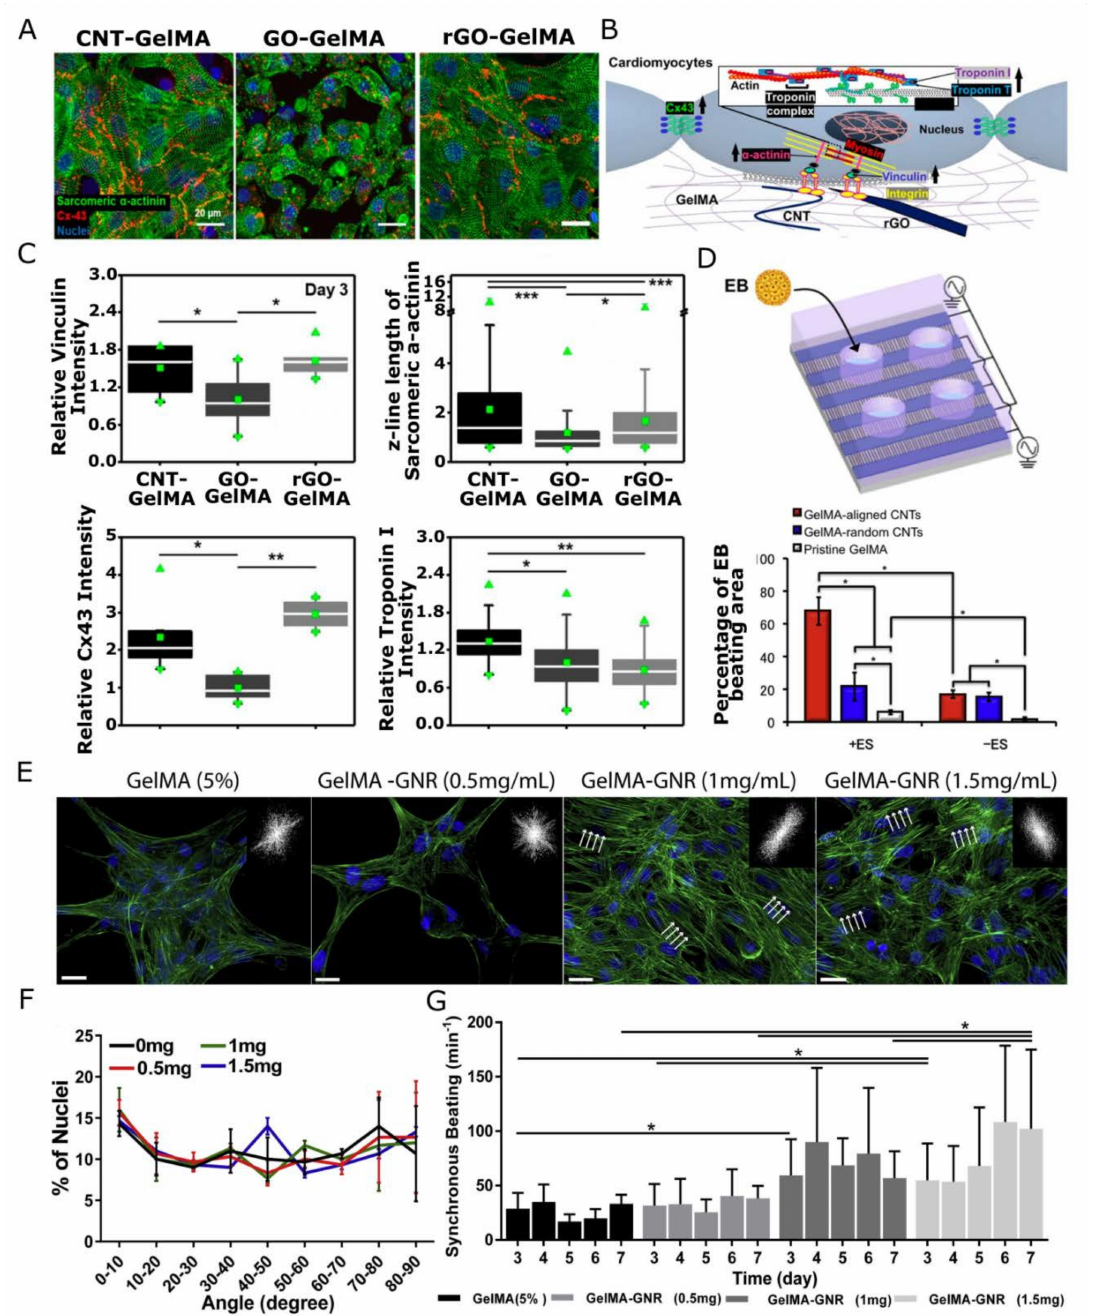
Figure 3. ( A ) Cardiac phenotypes on CNT-, GO-, and rGO-GelMA nanocomposite scaffolds. Flu- orescence microscopy image of cardiomyocyte culture, labeled for sarcomeric α -actinin (green), Cx-43 (red), and nuclei (blue). ( B ) Schematic representation of important functional proteins during cardiomyocyte maturation. ( C ) Relative intensity of vinculin, z-line length of sarcomeric α -actinin, connexin-43, and Tropinin I after 5 days of culture as determined from microscopy images as shown in panel ( A ) (* p < 0.05, ** p < 0.005, *** p < 0.005). ( D ) Schematic illustration of stem cell culture of mouse embryoid bodies (EBs) in GelMA containing 0.5 mg/mL random or aligned CNTs with electrical stimulation (ES) of 1 Hz, 3V and the percentage of beating EBs on pristine GelMA and CNT- GelMA in the presence (+ES) and absence ( − ES) of electrical stimulation after cardiac differentiation. (* p < 0.05) ( E ) Fluorescence confocal microscopy image showing F-actin (green) and nucleus (blue) staining of cardiomyocytes cultured within GelMA and GelMA-GNR hydrogels for 7 days. The